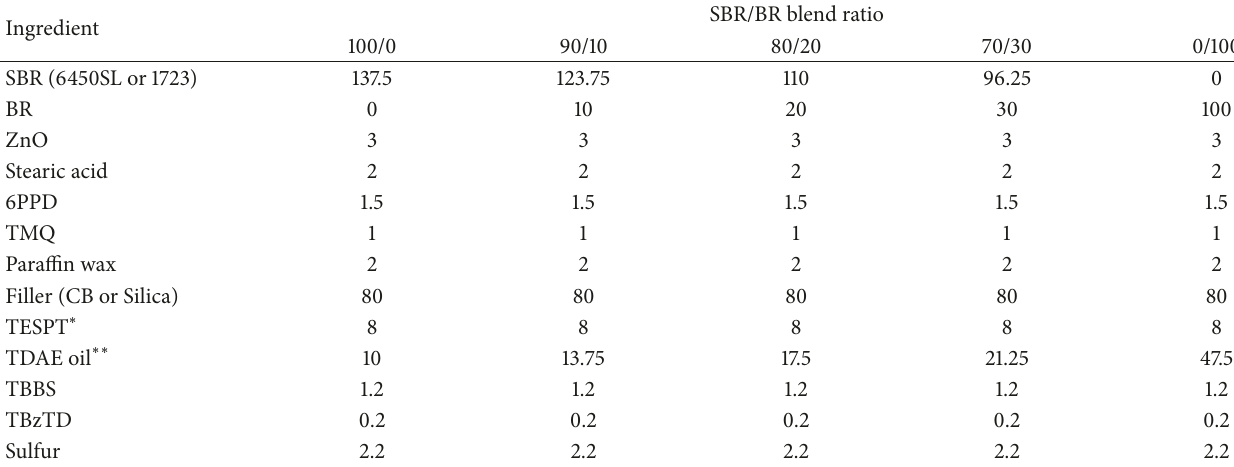
Table 2: Compound formulations.